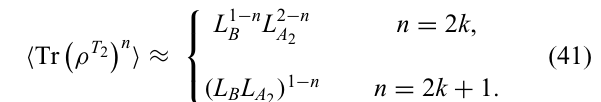
FIG. 4. Schematic representation of a tripartite random pure state in terms of Bell pairs (see the main text for more explana- tion). Each circle represents a qubit, and two qubits connected by a line represent a Bell pair. The three phases in Fig. 2 are illustrated for ten qubits: (a) Entanglement saturation regime, (b) maximally entangled regime, and (c) PPT